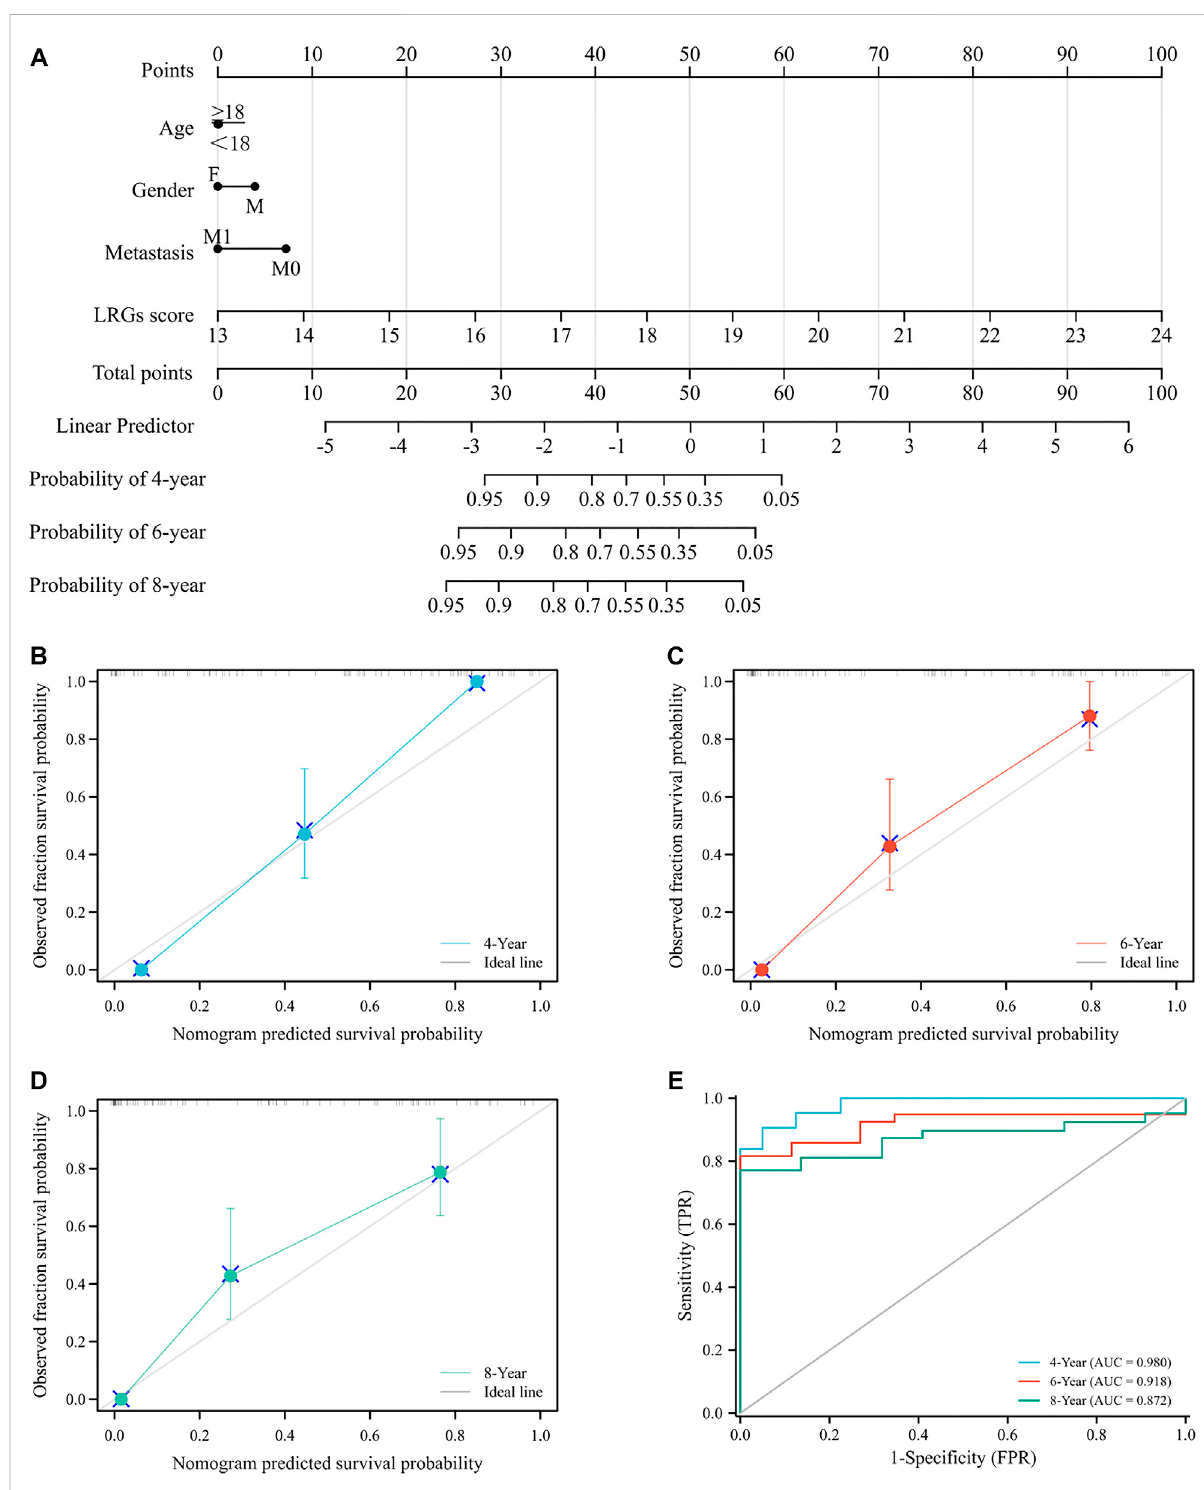
FIGURE 8 Construction and evaluation a novel nomogram for EWS patients (A) . Constructed nomogram to predict the 4, 6 and 8-year survival rate for EWS patients (B – D) . Calibration curve to verify the accuracy of the nomogram (E) . ROC curve of the